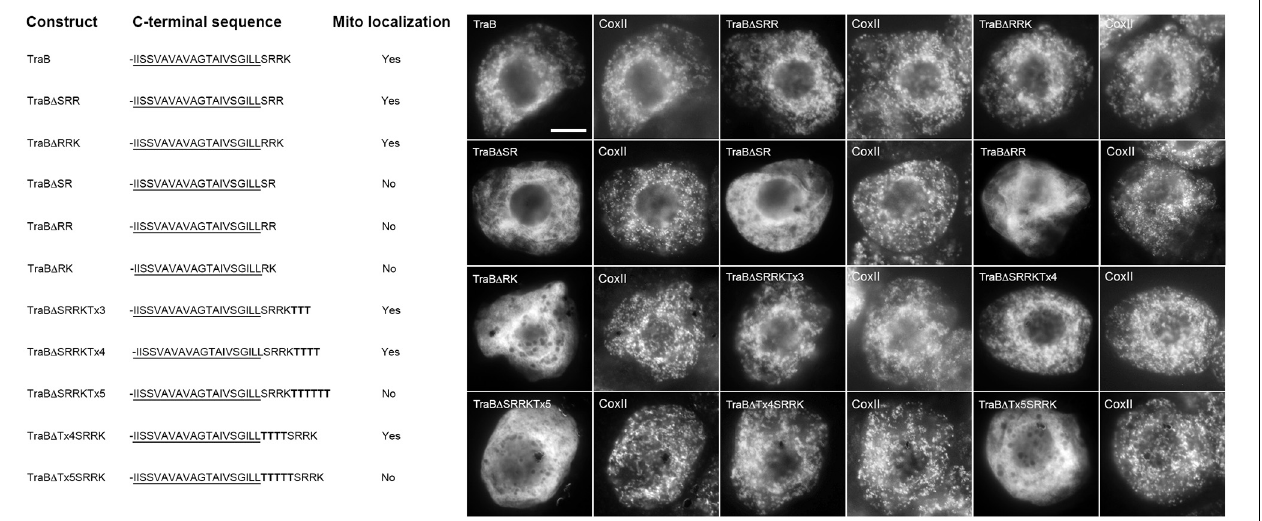
FIGURE 5 | Localization of various CTS mutant versions of the mitochondrial-TA proteinTraBinBY-2cells. Shown onthe left areschematic illustrations of wild-type and various CTS mutant versions of TraB and their corresponding localization (or lack thereof) to mitochondria in transformed BY-2 cells.Thenamesofthemutantconstructsrepresentthespecificaminoacidsin their modified CTSs. All constructs possess an N-terminal-appended Myc-epitope tag. Shown for each construct is the corresponding C-terminal amino acid sequence, including putative TMD (underlined) and modified (or